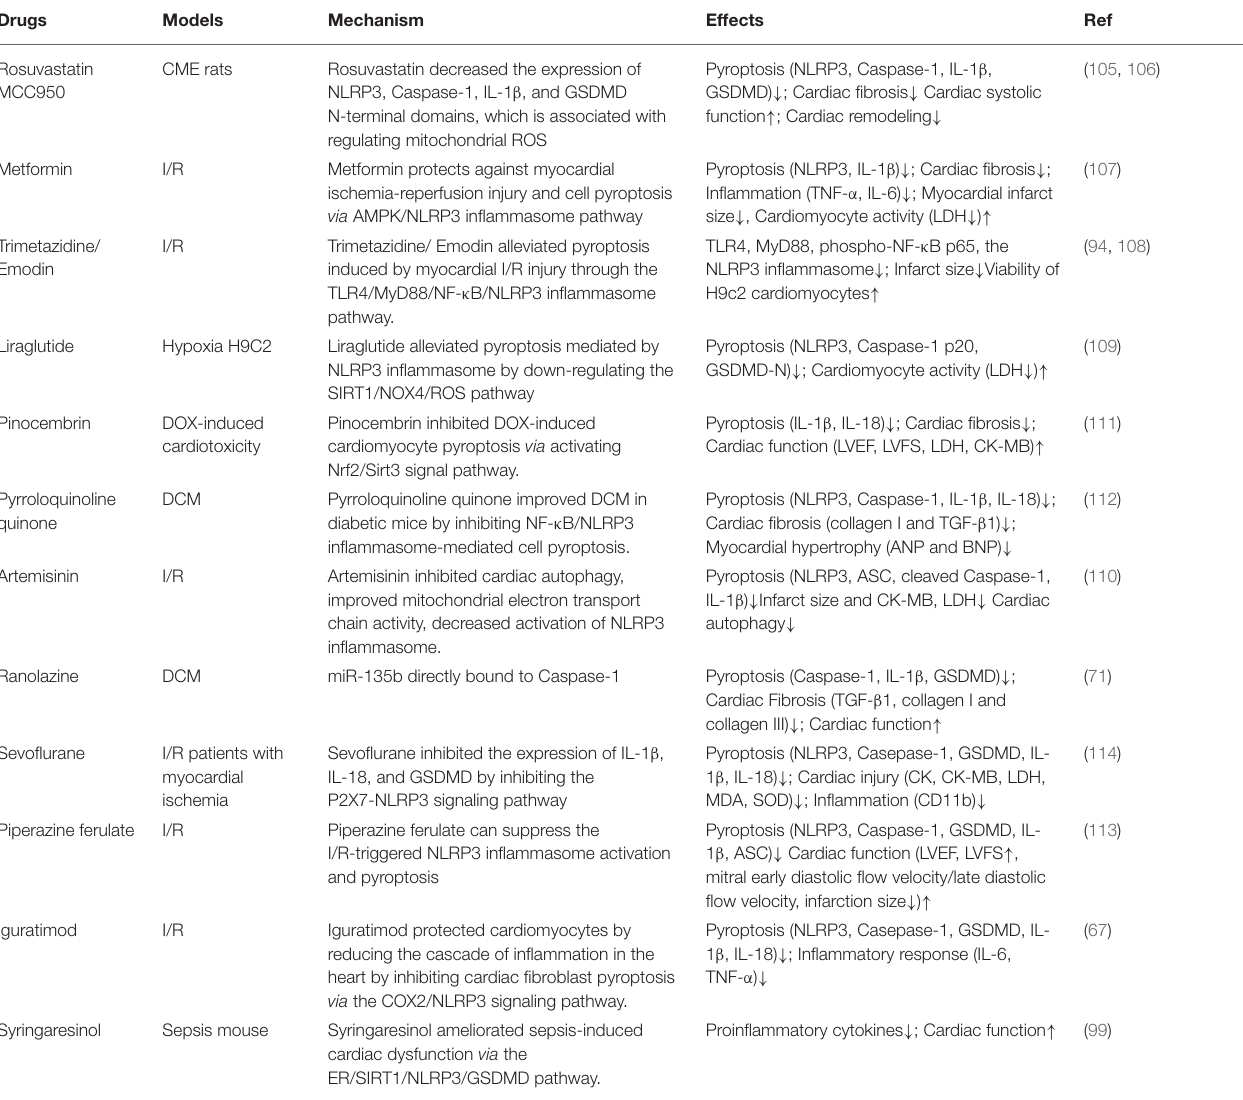
TABLE 1 | Therapy for improving cardiac remodeling by drugs on pyroptosis.